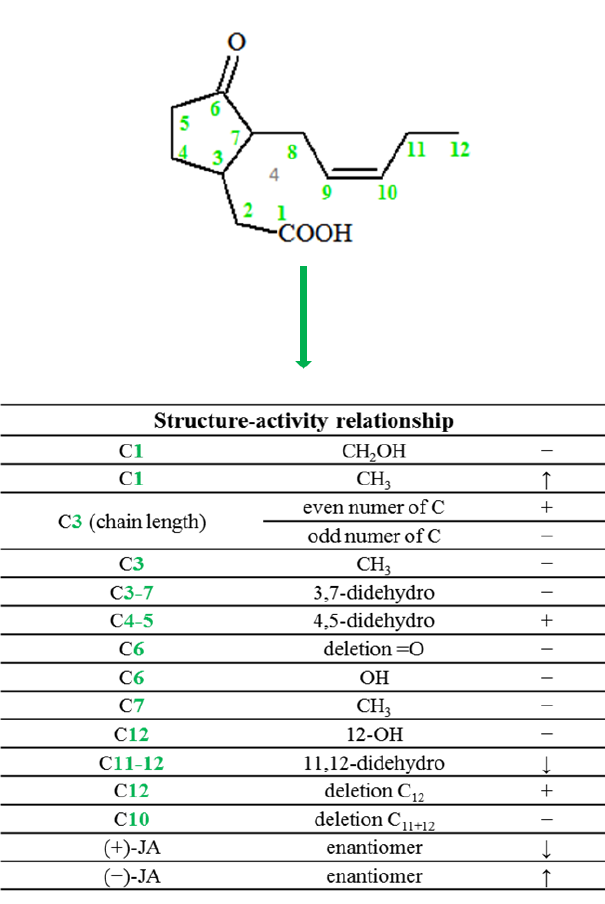
Figure 2. Structure-activity relationship of jasmonate compounds in relation to jasmonic acid. [ ↓ , decreased activity; ↑ , increased activity.; −, inactive; +, active].